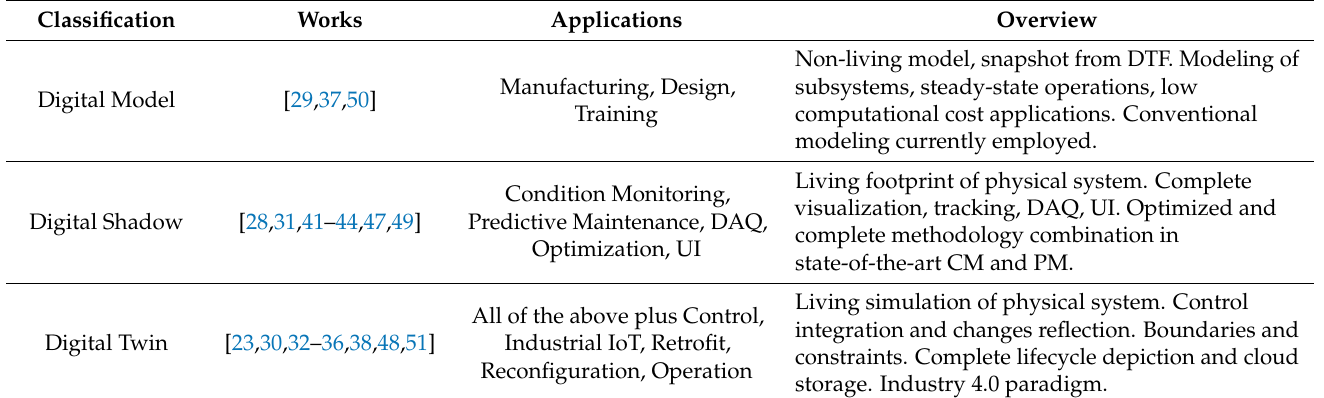
Table 3. Primary applications according to the different aspects of each classification.